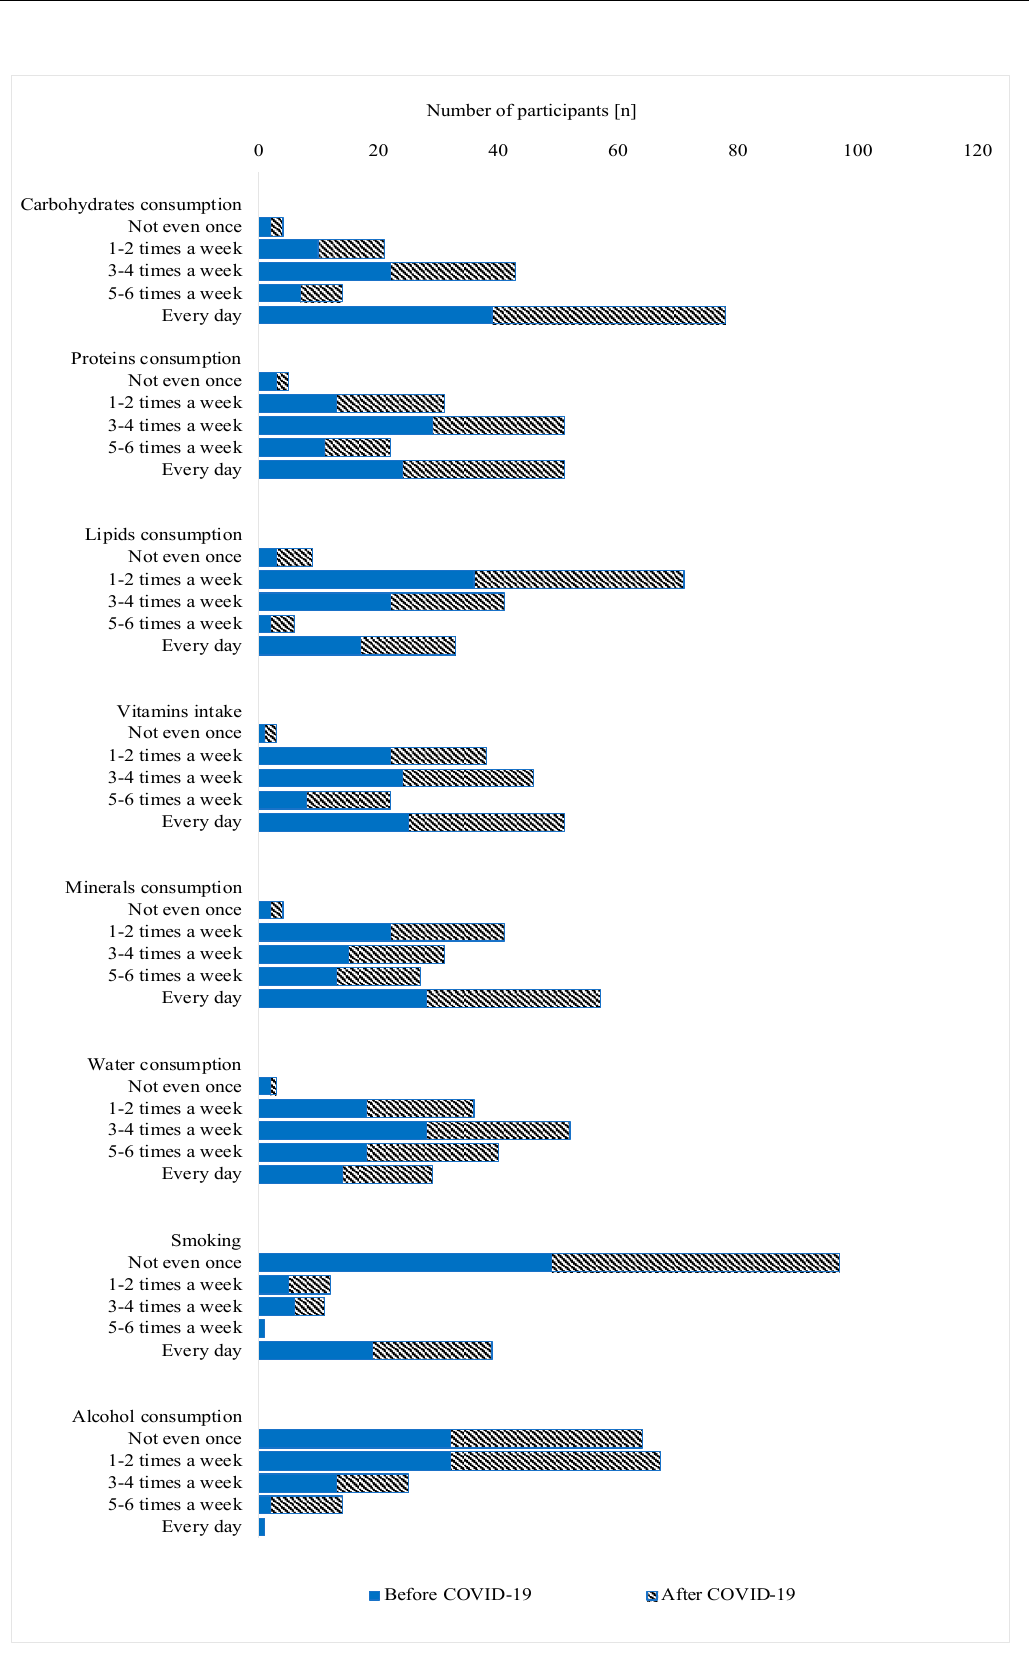
Figure 1. Assessment of weekly food intake and dietary habits of participants before and 6 months after COVID-19. Results are presented as number of patients out of total ( n = 80).